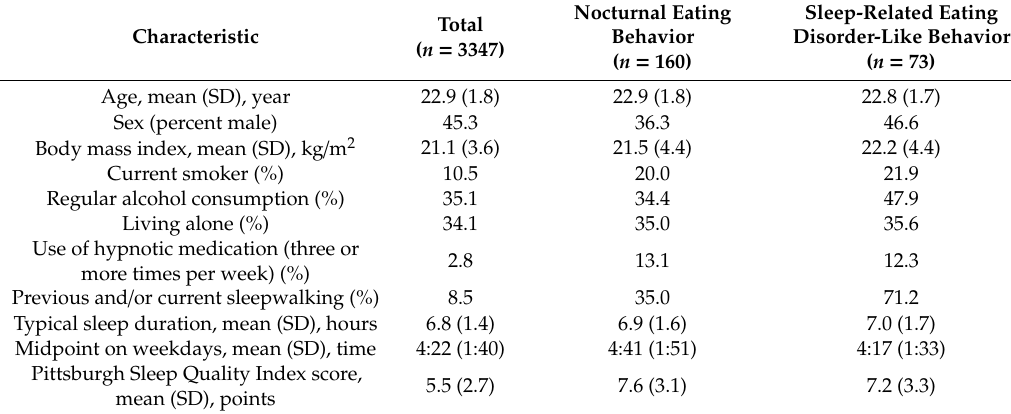
Table 1. Characteristics of study participants.